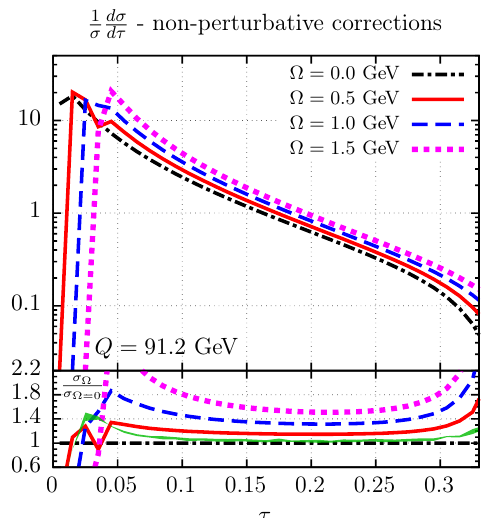
Figure 4. Comparison of the plain thrust NLO+NLL cross section under variation of the analytical hadronisation parameter (cid:10). The lower panel displays the ratios with respect to the case of vanishing non-perturbative corrections, i.e. (cid:10) = 0 GeV and the green band showing the hadron to parton level ratio for